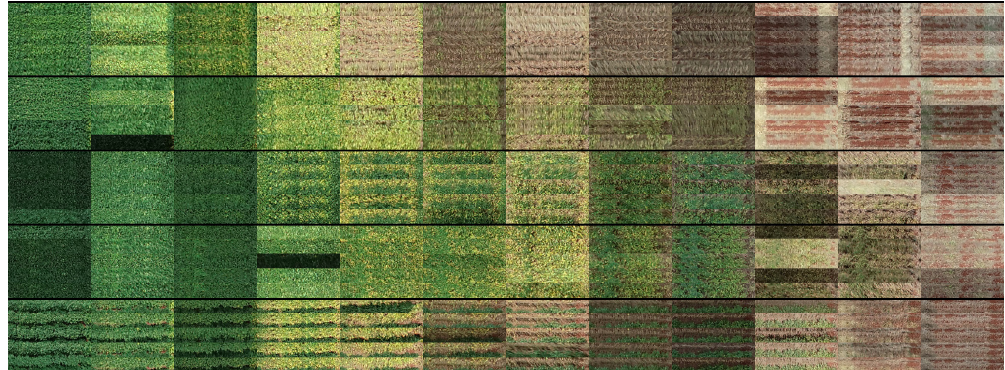
Figure 14. Examples of replicated images from trial T5 illustrating leaf retention, weeds and influence from neighboring